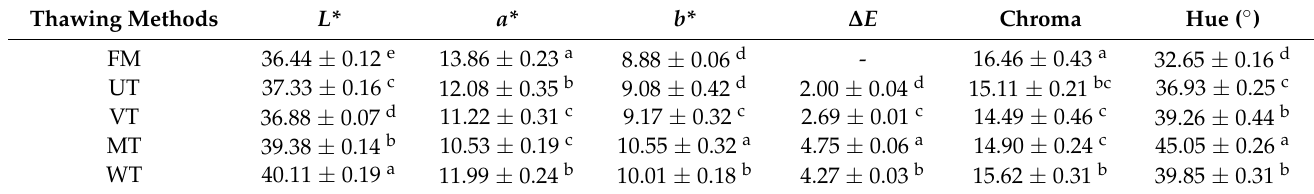
Table 2. Change in colour of porcine longissimus dorsi induced by thawing methods. Thawing